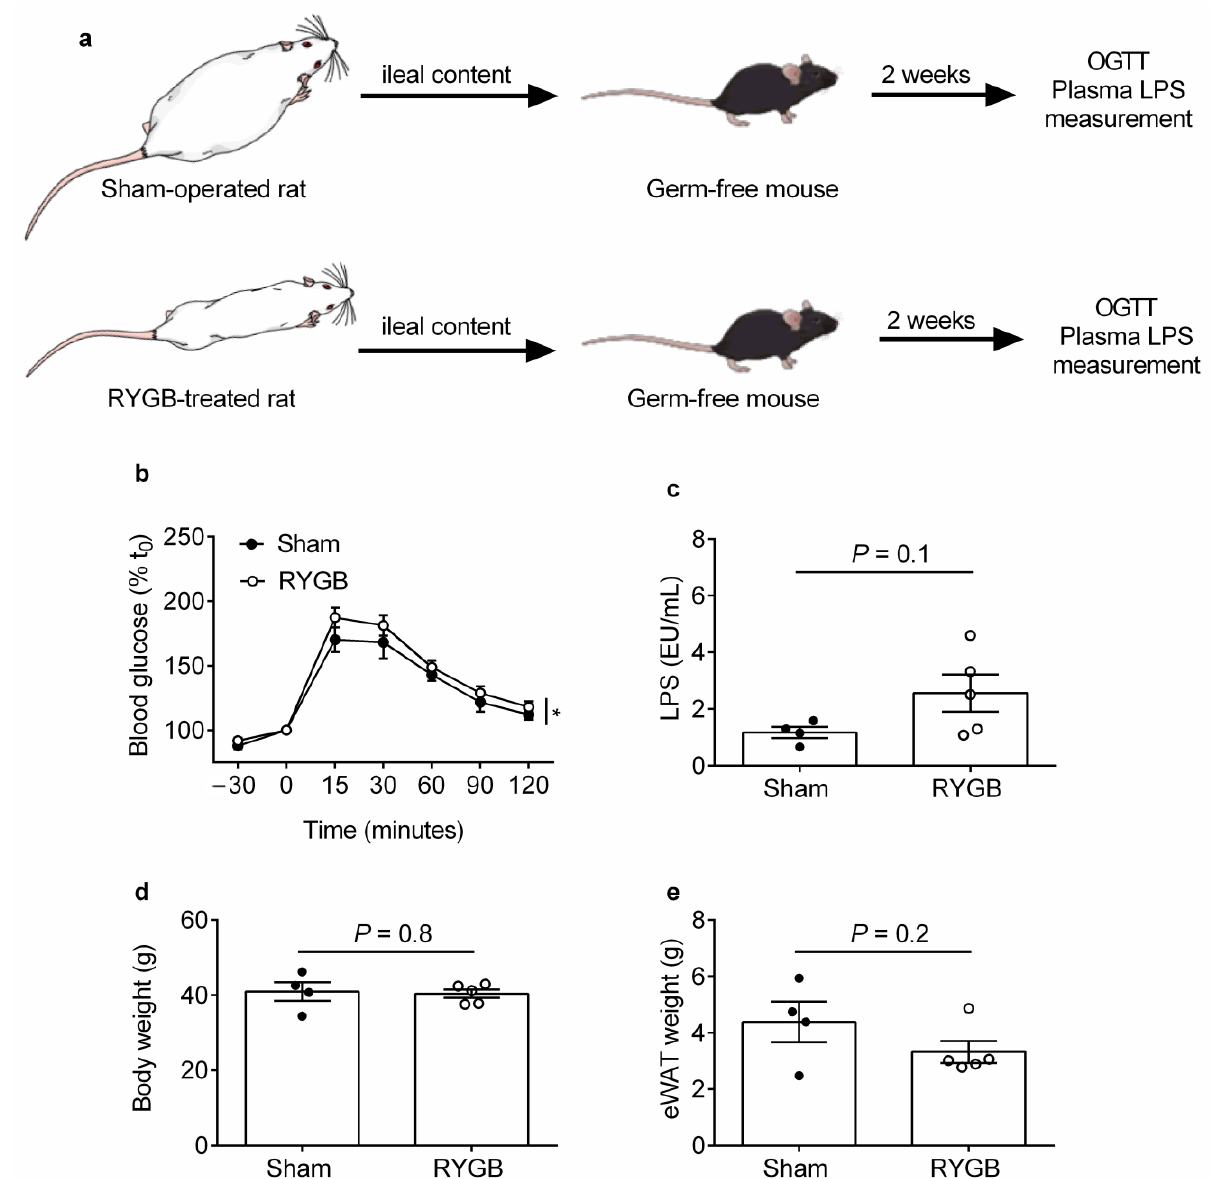
Figure 1. Ileal Content Transfer from RYGB-Treated Rats to Germ-Free Mice Modestly Impairs Oral Glucose Tolerance and Heightens Systemic Endotoxemia Development ( a ) Schematic diagram illustrating the ileal content transfer experiment performed on germ-free mice. ( b ) Percentage (%) change in tail vein blood glucose concentrations relative to t = 0 min (t 0 ) during the oral glucose tolerance test of germ-free mice that had received ileal content from RYGB-treated and sham-operated rats. ( c ) Plasma LPS concentrations, ( d ) body weight and ( e ) epididymal white adipose tissue (eWAT) weight from the mice in ( b ). n = 4–5 mice/group. Data are presented as mean ± SEM. Statistical significance was determined by two-way ANOVA (main effect of treatment) in ( b ) and two-tailed, unpaired t -test in ( c – e ). * p < 0.05.